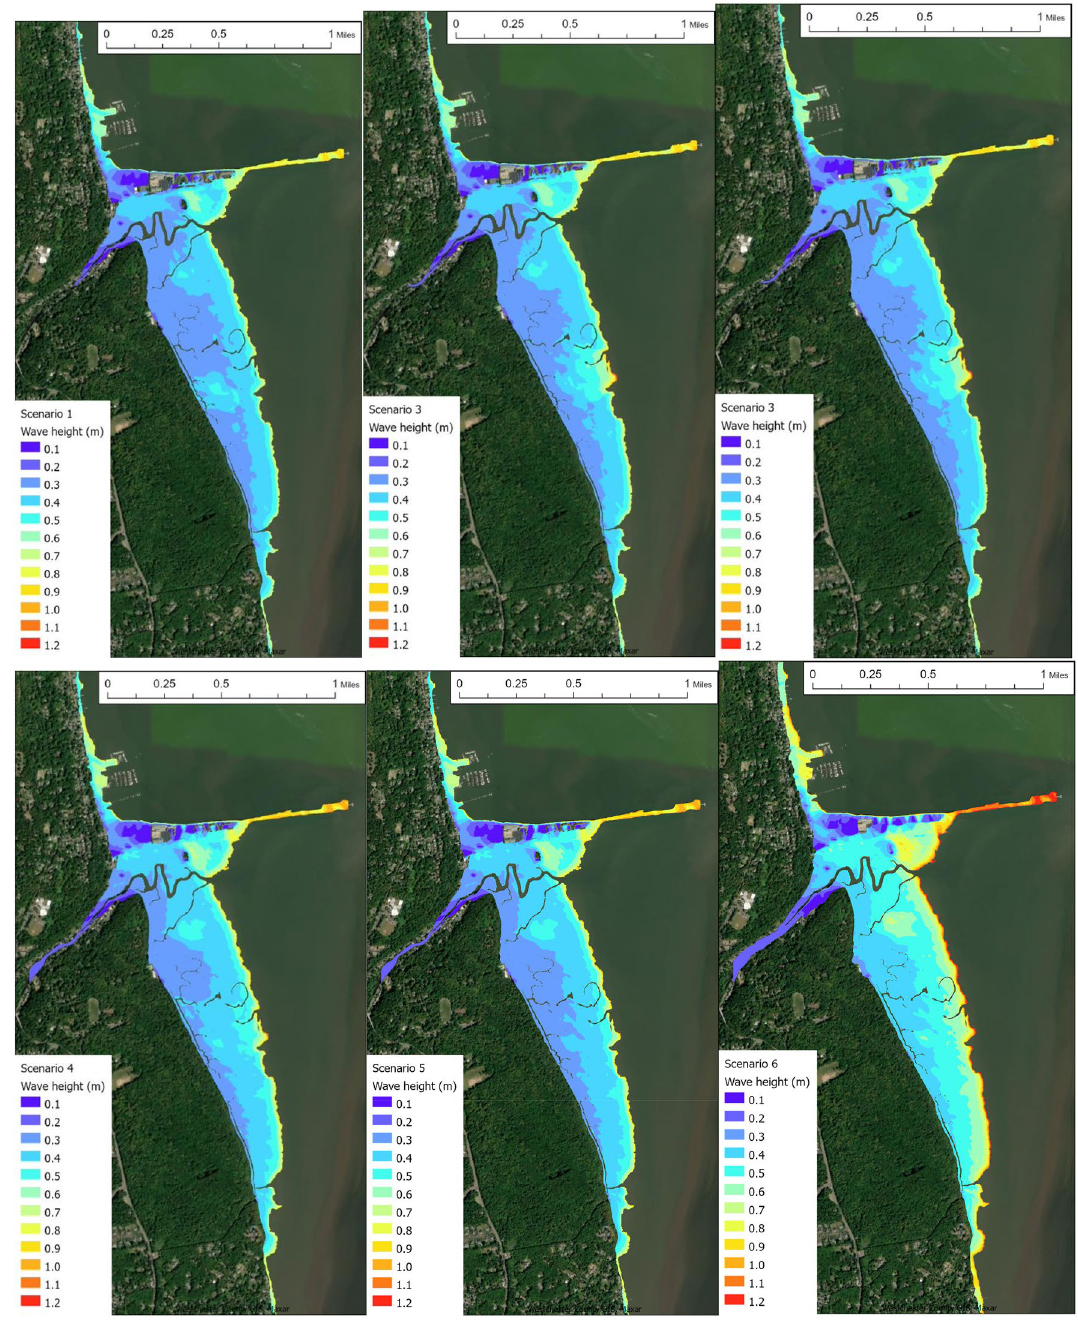
Westchester County GIS,